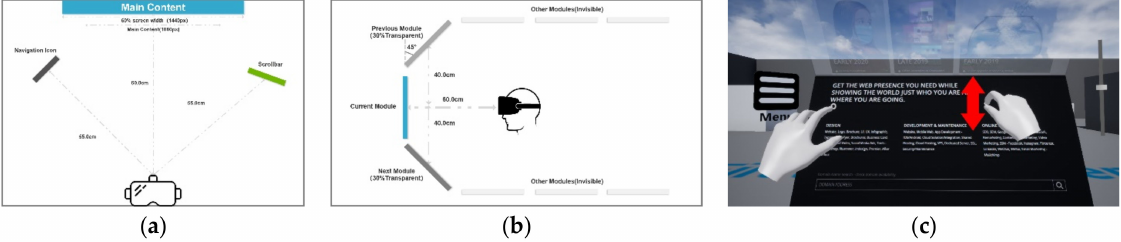
Figure 8. 3D layout plan: ( a ) Top view (concept) [21]; ( b ) Side view (concept) [21]; ( c ) Developing screenshot (use gesture to scroll the